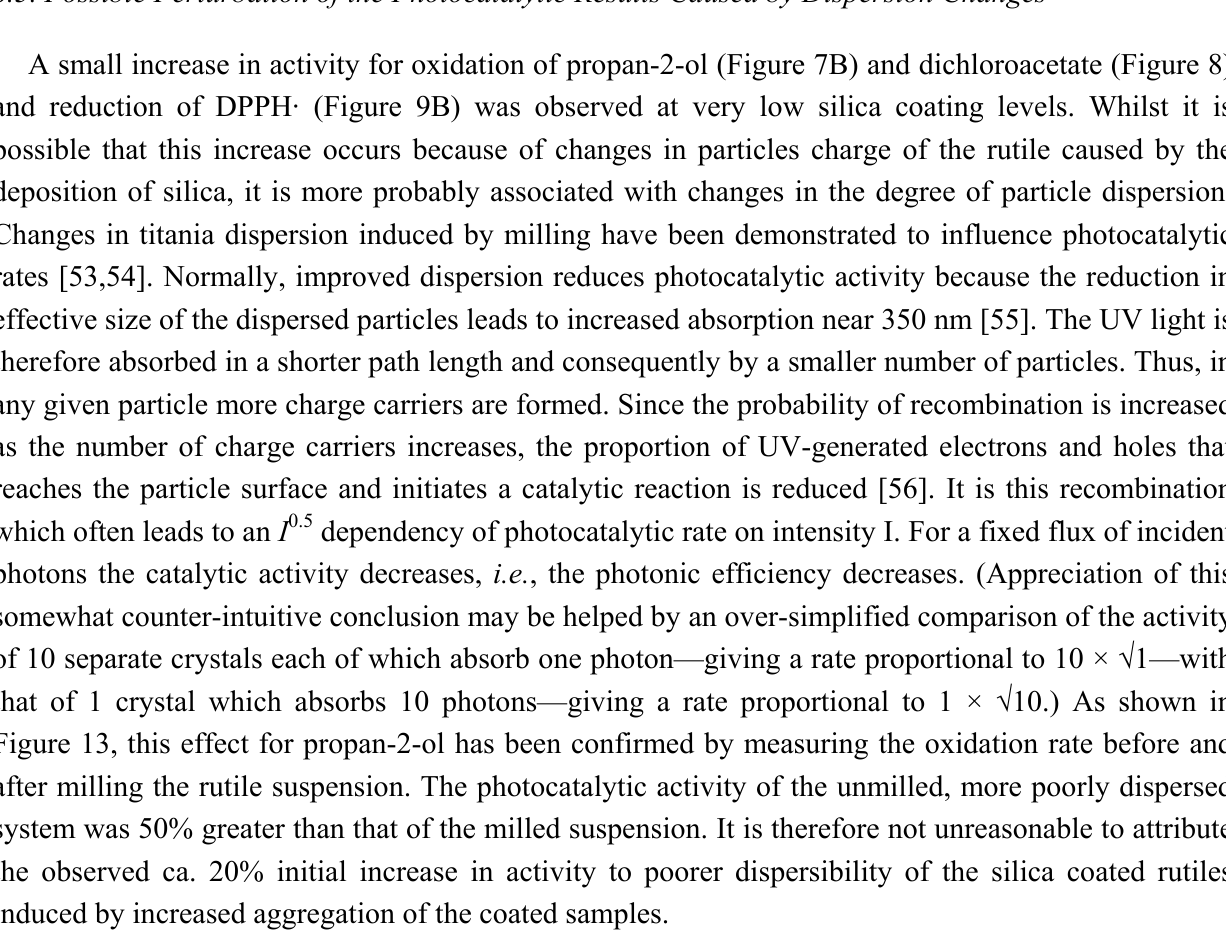
Figure 13. Decreased rate of photocatalytic oxidation of propan-2-ol to acetone caused by 30 min milling of the high area rutile #2. 0 min. mill (—, ▲ ); 30 min. mill (---, ■ )